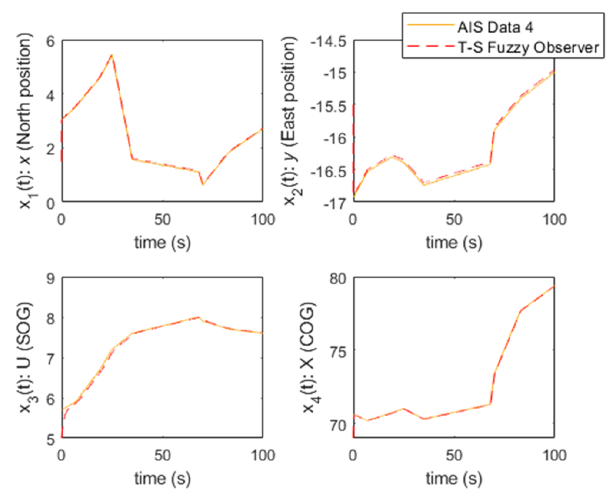
Figure 13. Simulation results of AIS data 4.